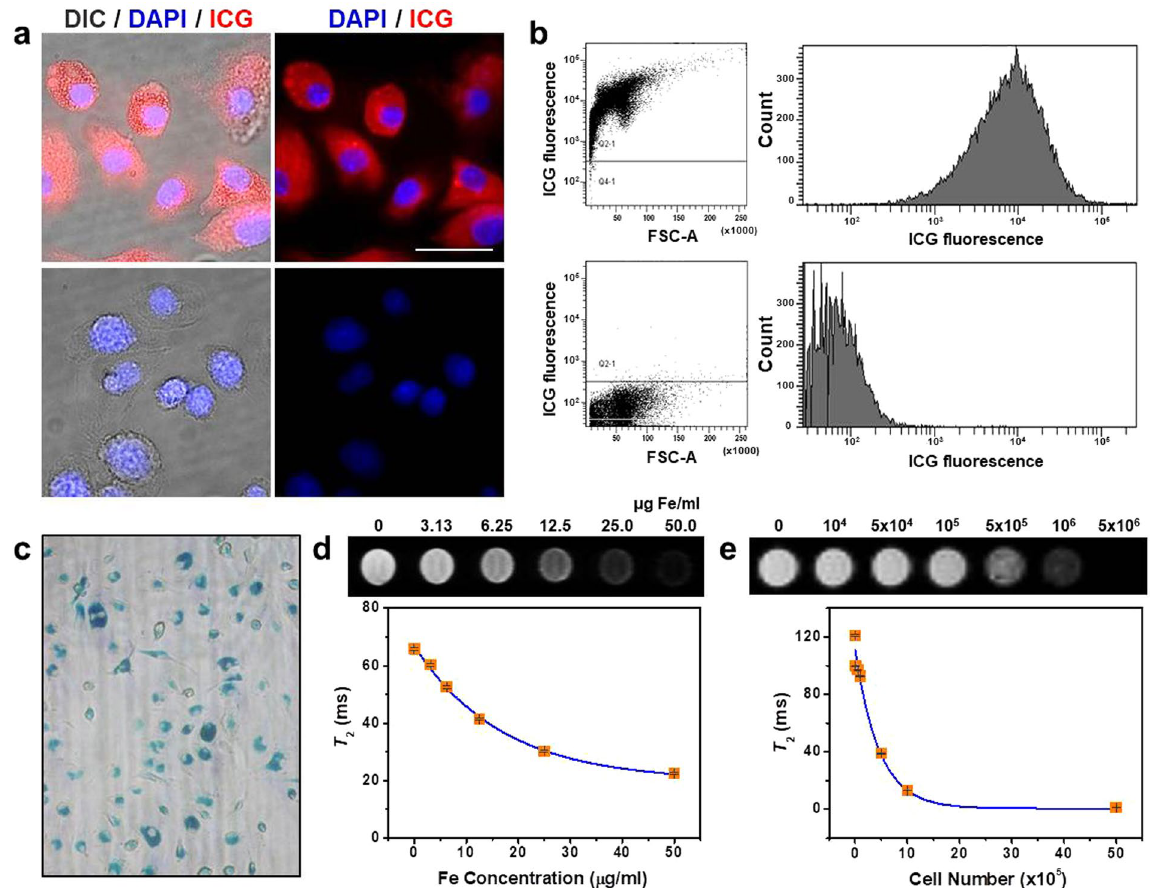
Figure 4. In vitro MR/FL imaging of cells labeled with ICGylated MNPs. ( a ) In vitro microscope images and ( b ) flow cytometric analysis of the labeled DCs with ICGylated MNPs (top) and those of the unlabeled ones (bottom). Blue and red colors represent DAPI-stained nuclei and ICG fluorescence. The scale bar indicates 15 μ m in ( a ). ( c ) Prussian blue staining of the labeled DCs incubated with 25 µ g Fe/ml of ICGylated MNPs for 24 h. ( d ) T 2 -weighted MR images (top) and T 2 values (bottom) for the labeled DCs (5 × 10 6 ) as a function of treated Fe concentration. ( e ) Same as ( d ) but as a function of the cell number with DCs labeled at a concentration of 100 µ g Fe/ml of ICGylated